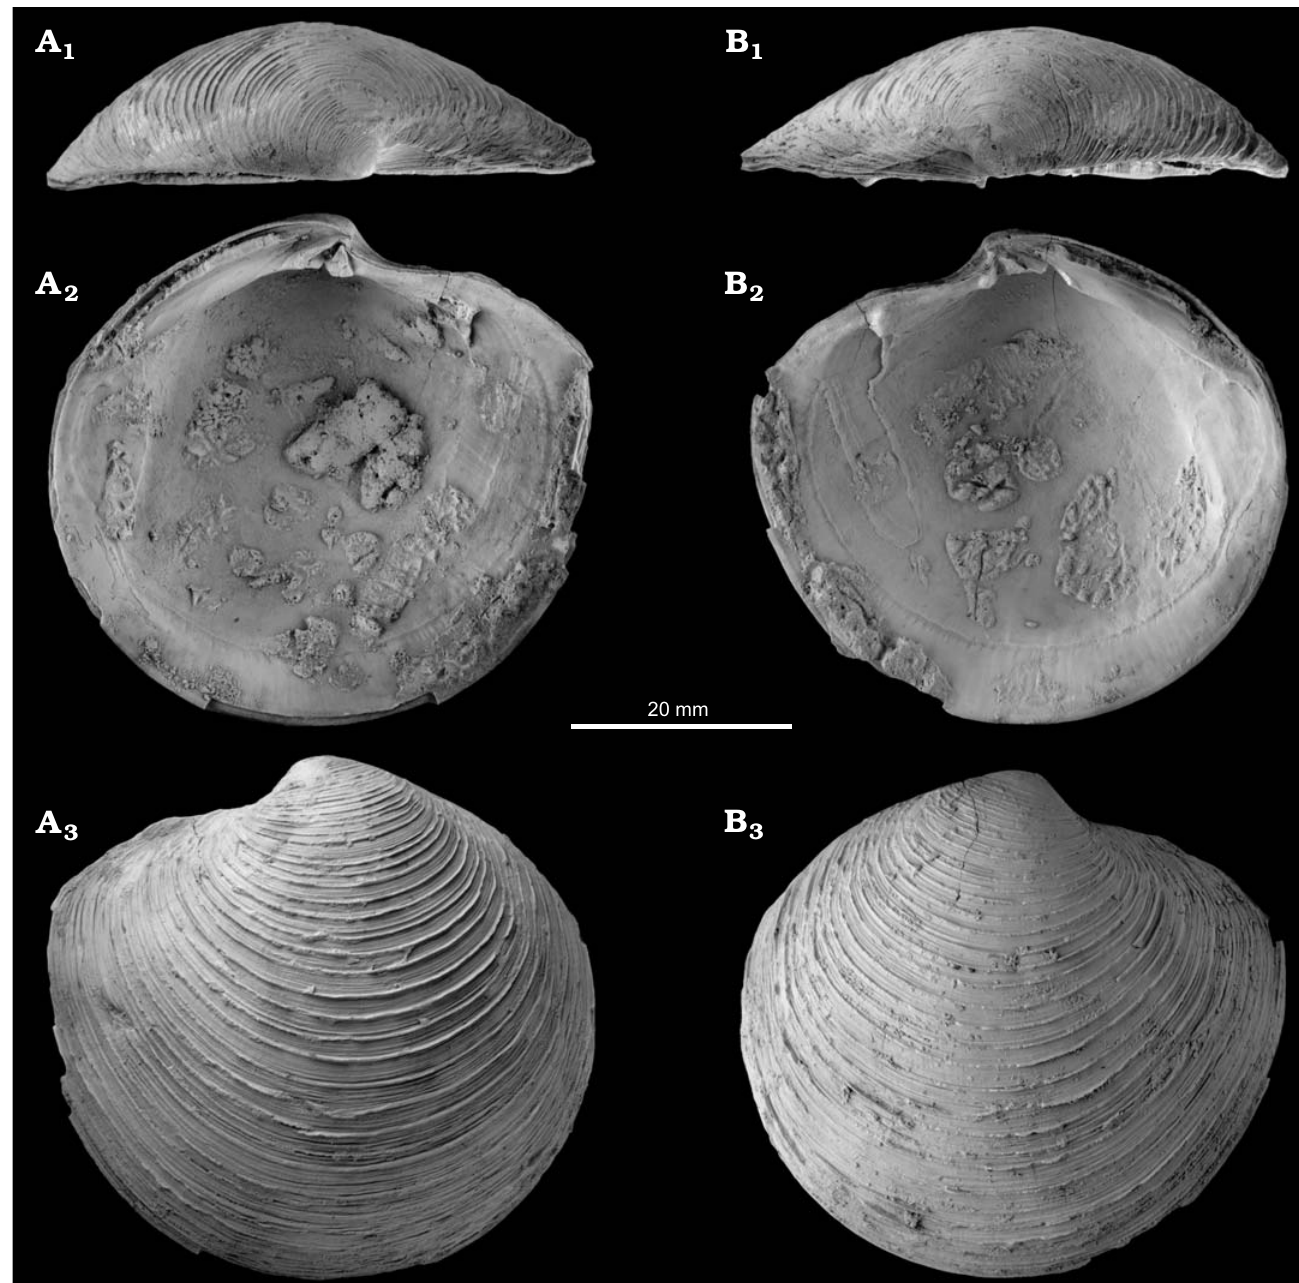
Fig. 6. The lucinid bivalve Lucinoma persolida (Sacco, 1901) from the late Pliocene of Italy, Stirone River seep deposit. MGGC.22014, left ( A ) and right ( B ) valves; in dorsal views (A 1 , B 1 ), views of the interior including hinge and muscle attachment scars (A 2 , B 2 ), and views of exterior (A 3 , B 3